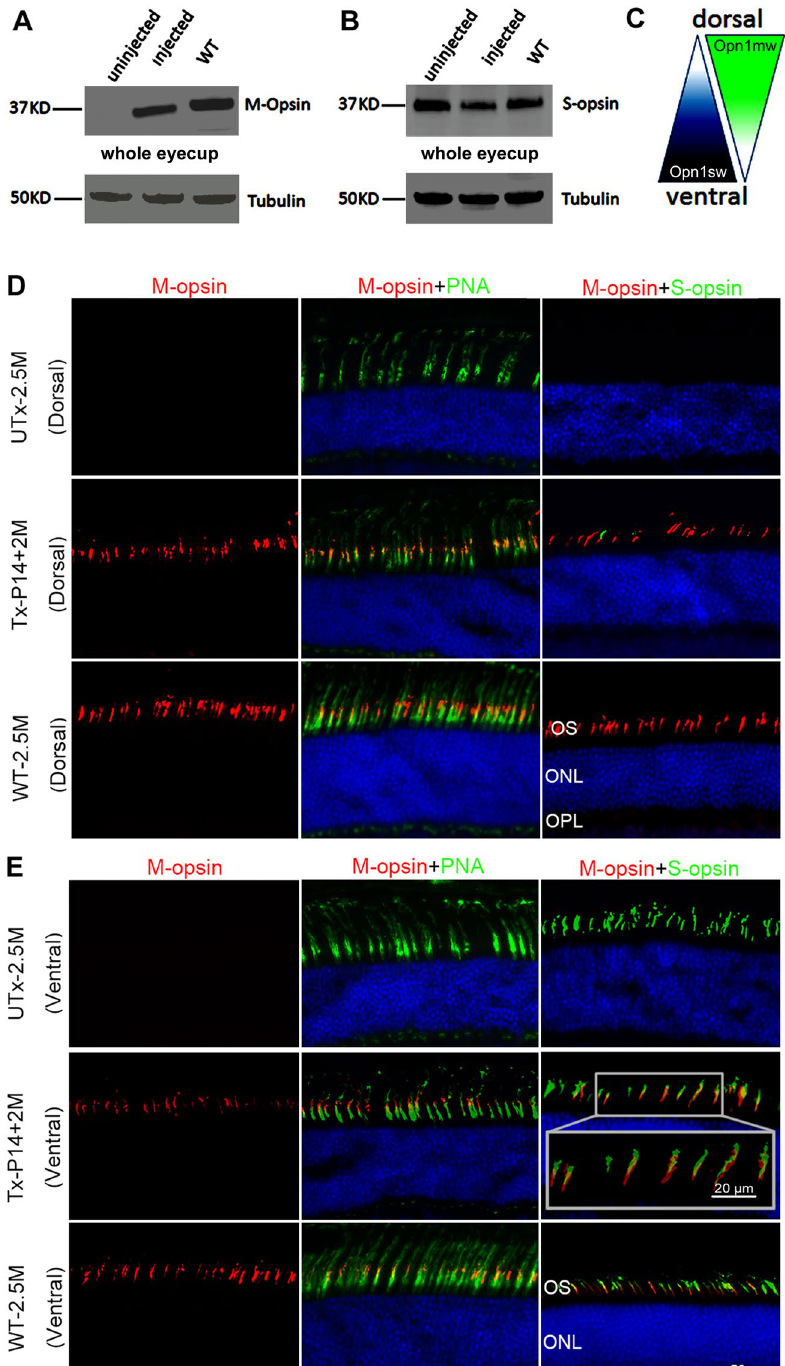
Figure 1. Comparison of M- and S-opsin in Opn1mw − / − and WT mice. P14 Opn1mw − / − mice were treated with AAV5-PR2.1-mouse M-opsin vector and western blot analysis of mouse M-opsin ( A ) and S-opsin ( B ) was performed at 2 month post-injection with age-matched wild type eyes (WT); Tubulin was served as loading control. Diagram of M- and S-opsin distribution in WT retina was shown in ( C ). Frozen sections were prepared for immunostaining from dorsal ( D ) and ventral ( E ) retina of 2.5-month-old untreated Opn1mw − / − mice (UTx-2.5M), Opn1mw − / − mice treated at P14 and analyzed at 2 months post-injection (Tx-P14 + 2 M), and age- matched wild type control mice (WT-2.5M). ( D ) Analysis of the dorsal retina with M- and S-opsin antibodies and PNA. Neither M- nor S-opsin was detected in the dorsal retinas of the untreated eye (UTx-2.5M), but PNA staining was normal. In the treated eye (Tx-P14 + 2 M), AAV-delivered M-opsin was now abundant in the dorsal retina and co-localized with PNA. In an untreated age-matched wild type eye (WT-2.5M), M-opsin is found co-localized with PNA with very little or no S-opsin in the dorsal retina. ( E ) Analysis of the ventral retina. S-opsin expression and PNA staining were normal in the untreated Opn1mw − / − ventral retina